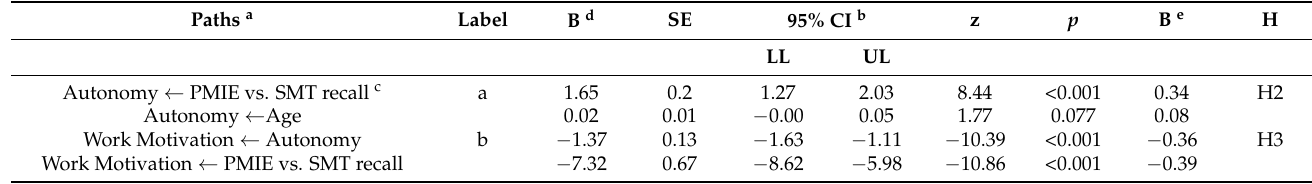
Table A2. Path analysis parameter estimates after outlier